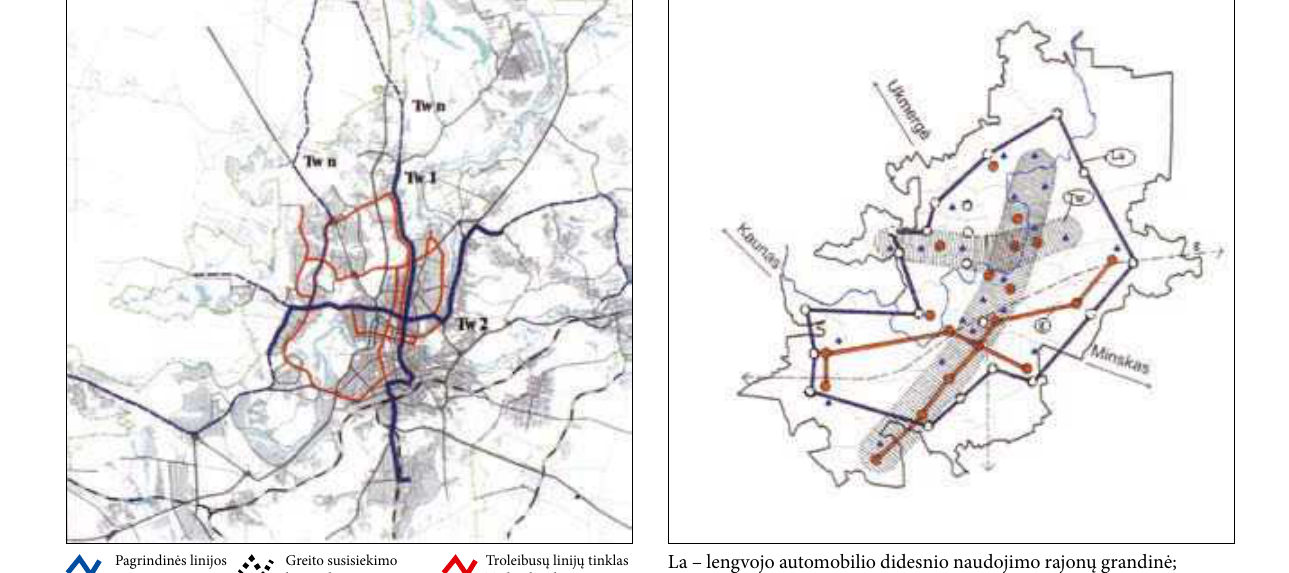
linesPagrindinės linijos Main routes